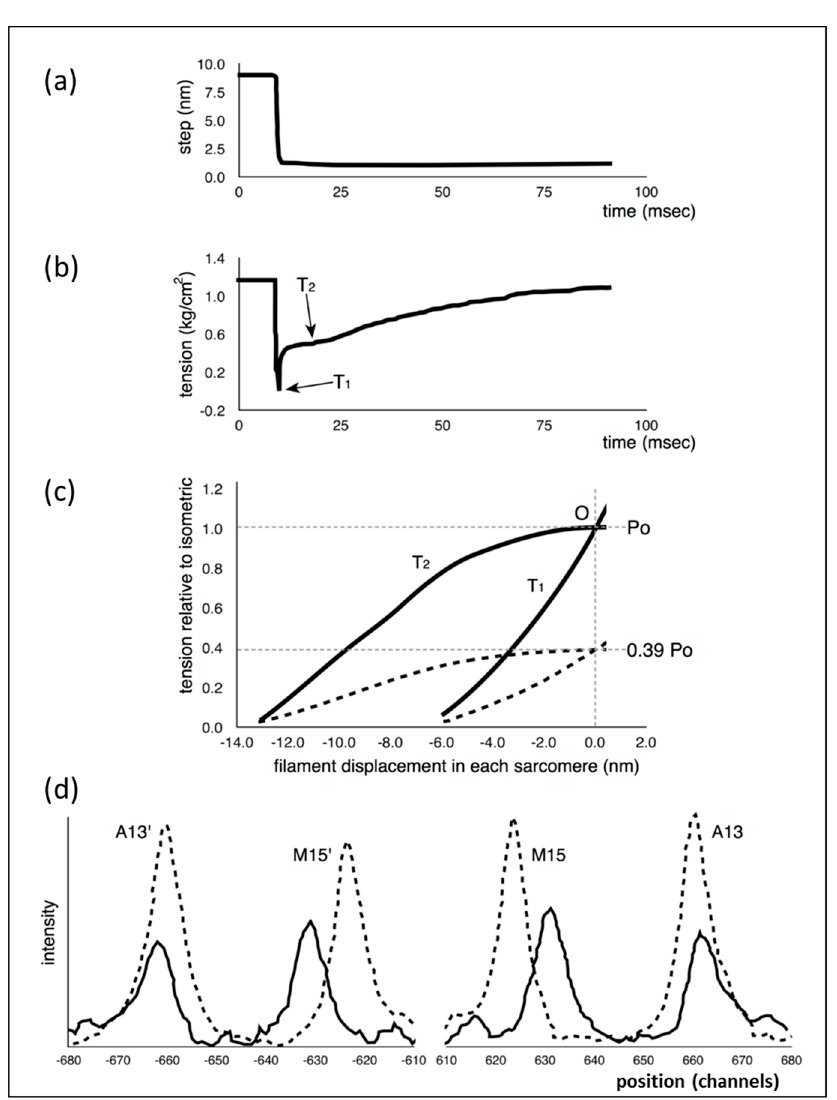
Figure 1. Previous observations: ( a , b ) representation of the observations of Huxley and Simmons [2] (as improved by [3,4]) showing the tension transient ( b ) in an active frog muscle fibre after a rapid shortening step ( a ) of about 6 nm (60 Å) per half sarcomere and the point where the T 1 tension was recorded ( b ). ( c ) The T 1 and T 2 plots from experiments as in ( a ), but for different shortening steps (filament displacement per half sarcomere) and shown at two different sarcomere lengths—solid lines full overlap, dashed lines 3.1 µm. P o is the isometric tension at the tension plateau. ( d ) Representation of the results from Huxley et al. [5] showing the change in positions of the M15 (M15 ′ on the opposite side) and A13 (A13 ′ ) meridional X-ray diffraction peaks from myosin and actin filaments respectively at rest (solid lines) and full activation (dashed lines). The peaks shift towards the middle (longer spacings) and increase in intensity in X-ray patterns from active muscle. Wakabayashi et al. [6] obtained similar results. Figures redrawn from ( a , b , c ) [2] and ( d ) [6]. For details, see text.